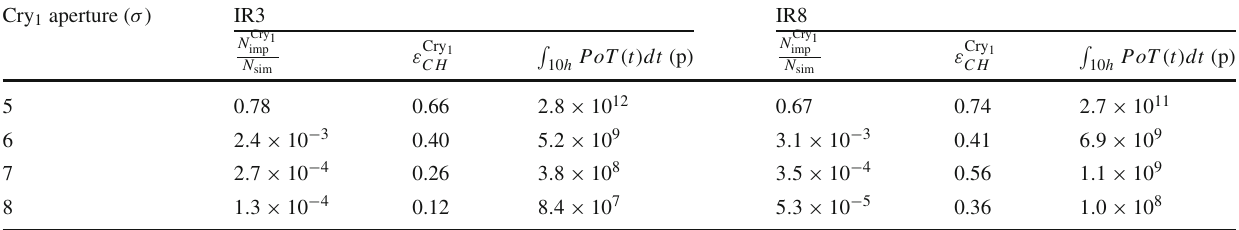
is considered for all cases, except for the IR8 layout with Cry 1 at 5 σ , where 256 bunches are used as discussed in Sect. 6.3